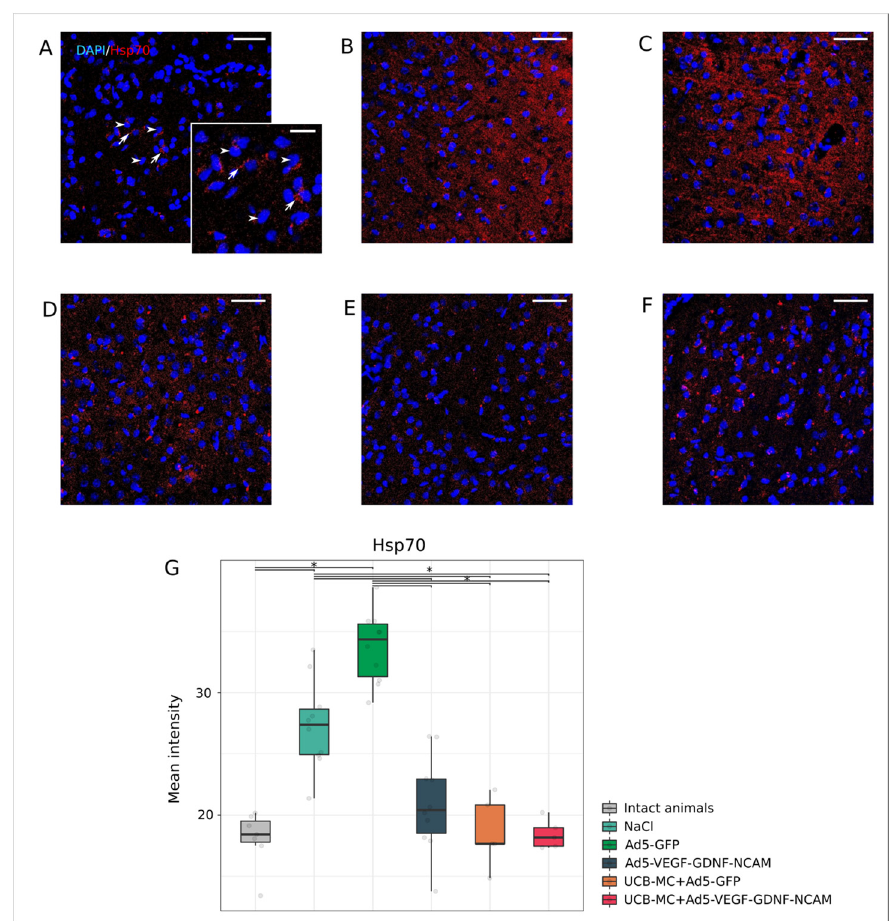
Figure 3. Immunoexpression of Hsp70 in the rat brain cortex, 21 days after the middle cerebral artery occlusion. Immunofluorescent staining with antibody to heat shock protein 70 kDa in intact ( A ), control NaCl ( B ) and Ad5-GFP ( C ), and therapeutic UCB-MC + Ad5-GFP ( D ), Ad5-VEGF-GDNF-NCAM ( E ) and UCB-MC + Ad5-VEGF-GDNF-NCAM ( F ) groups. Arrows indicate cytoplasmic localization of Hsp70 (red glow) in brain cells. Arrowheads point to cell nuclei visualized using DAPI (blue glow). Scale bar in ( A – F ) = 50 µ m; scale bar in the insert = 20 µ m. ( G )—comparative analysis of fluorescence intensity level of Hsp70 in experimental groups; *— p <